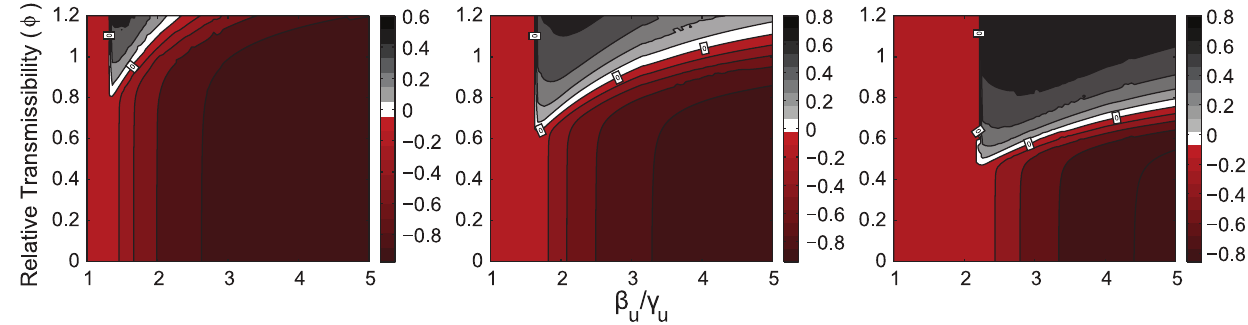
Figure 8. FS res { FS w in the ( b u = ª u , w ) parameter space. c u is fixed, and r ~ 0 : 3,0 : 5,0 : 7 (left to right). Gray-black regions are dominated by the resistant strain. As treatment increases the resistant strain 1) benefits from higher wild-strain transmissibility, 2) increases the range of relative transmissibility for which it can spread, and 3) expands the region in which it can extensively spread (black region).